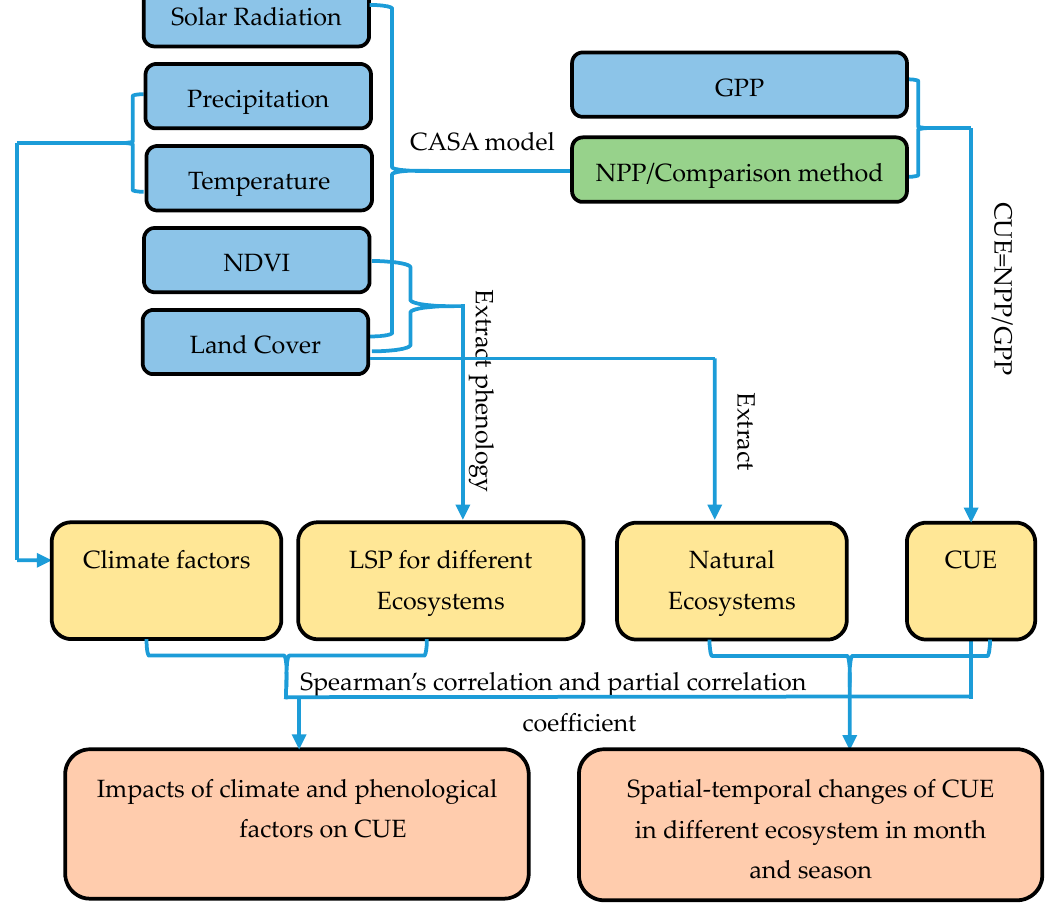
Figure 2. The flow chart of the research approach.